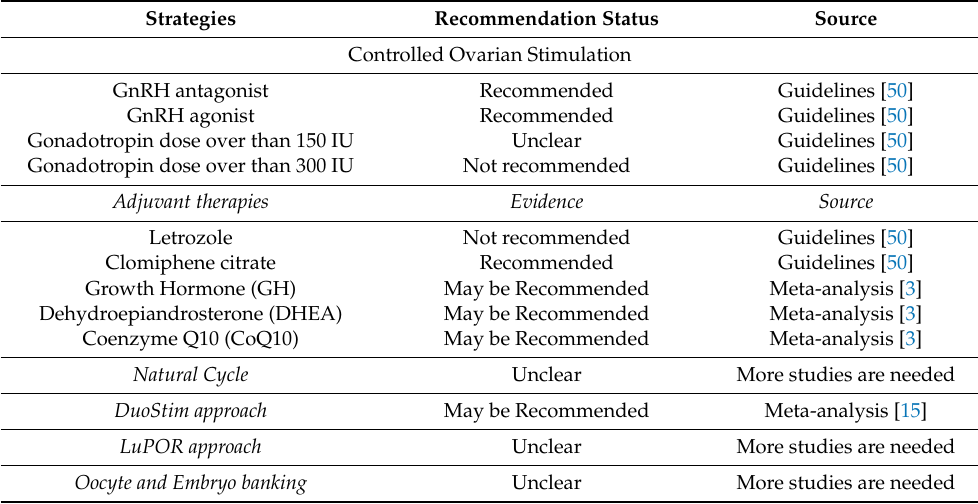
Table 1. Recommendation status regarding clinical application of current strategies employed for addressing poor ovarian response according to published